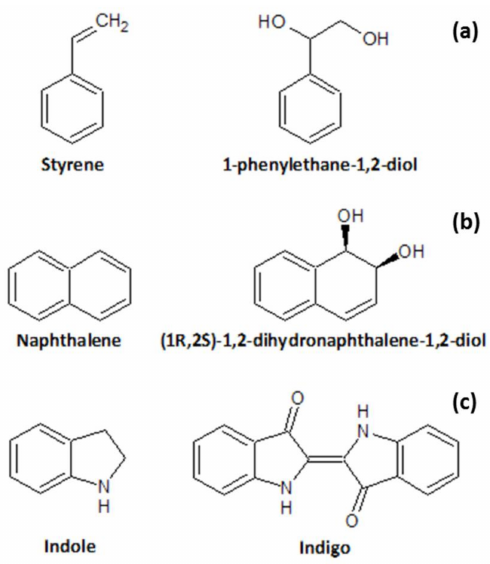
Figure 2. Substrate (left) and corresponding dihydroxylation product (right) for the biotransformation performed ( a ), the natural naphthalene dioxygenase (NDO) substrate ( b ) and the substrate for induction screening, indole ( c